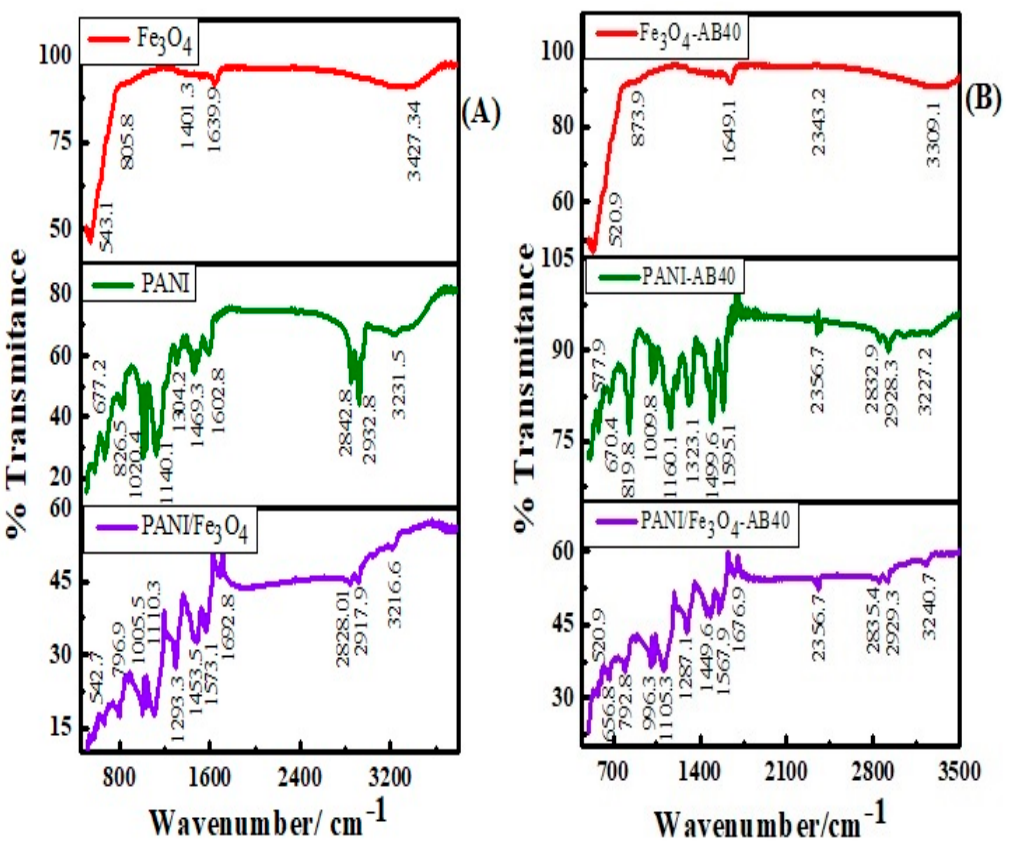
Figure 4. FTIR spectra of Fe 3 O 4 , PANI and PANI / Fe 3 O 4 composites before ( A ) and after ( B ) the adsorption of AB40.